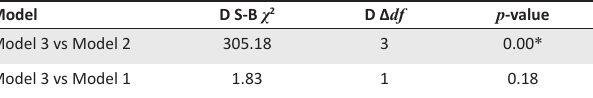
TABLE 5: Difference testing for changes in chi-square in competing structural